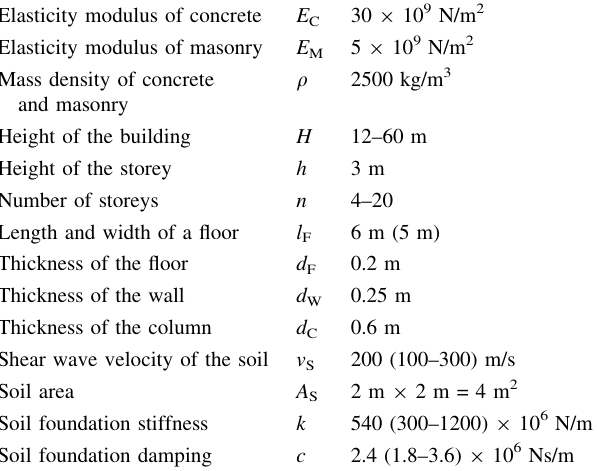
Table 2 Parameters of the immission